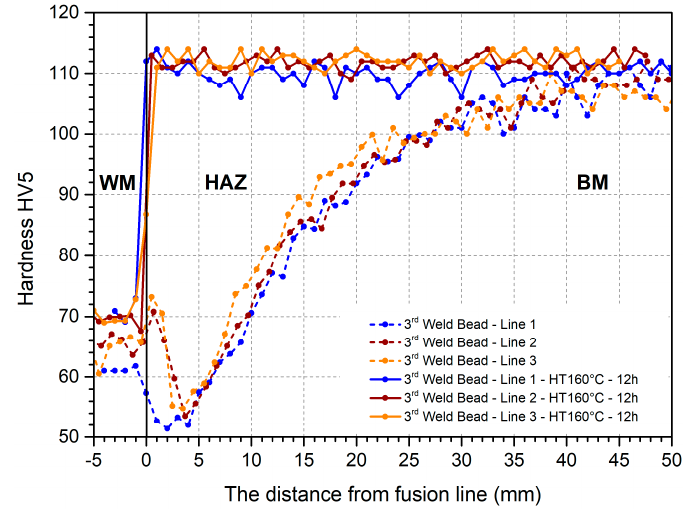
Figure 13. Measured hardness values in the weld metal, HAZ and base material for weld 2 (with preheating at 150 °C) in the zones of lines 1, 2 and 3 after welding and after age-hardening at 160 °C for 12 h.